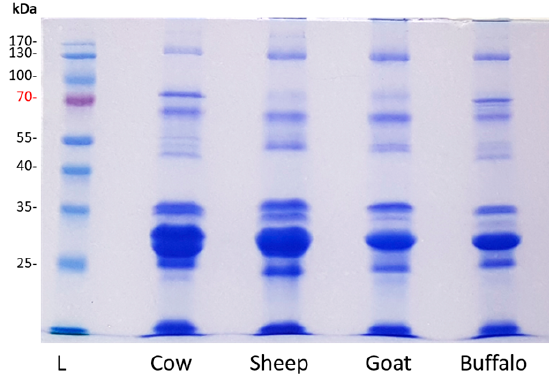
Figure 1. SDS-PAGE analysis of proteins isolated from a fraction of cream from cow, sheep, goat, and buffalo. L: prestained protein ladder with molecular weights indicated.